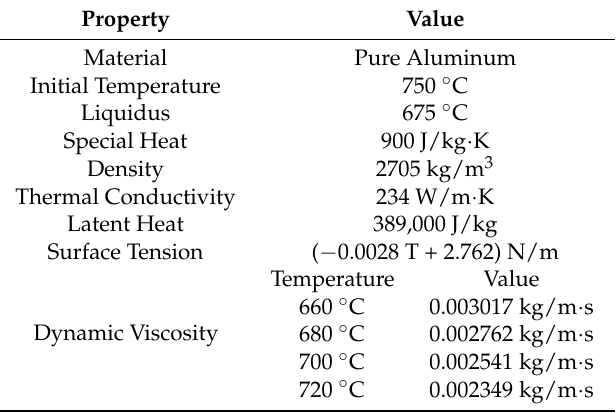
Table 3. Thermophysical properties of melt in the